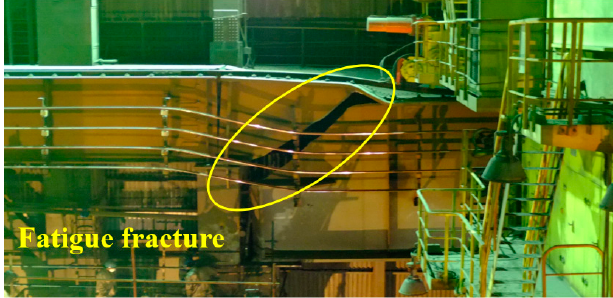
Figure 1. Fatigue fracture of a variable-section support of a steel crane girder.